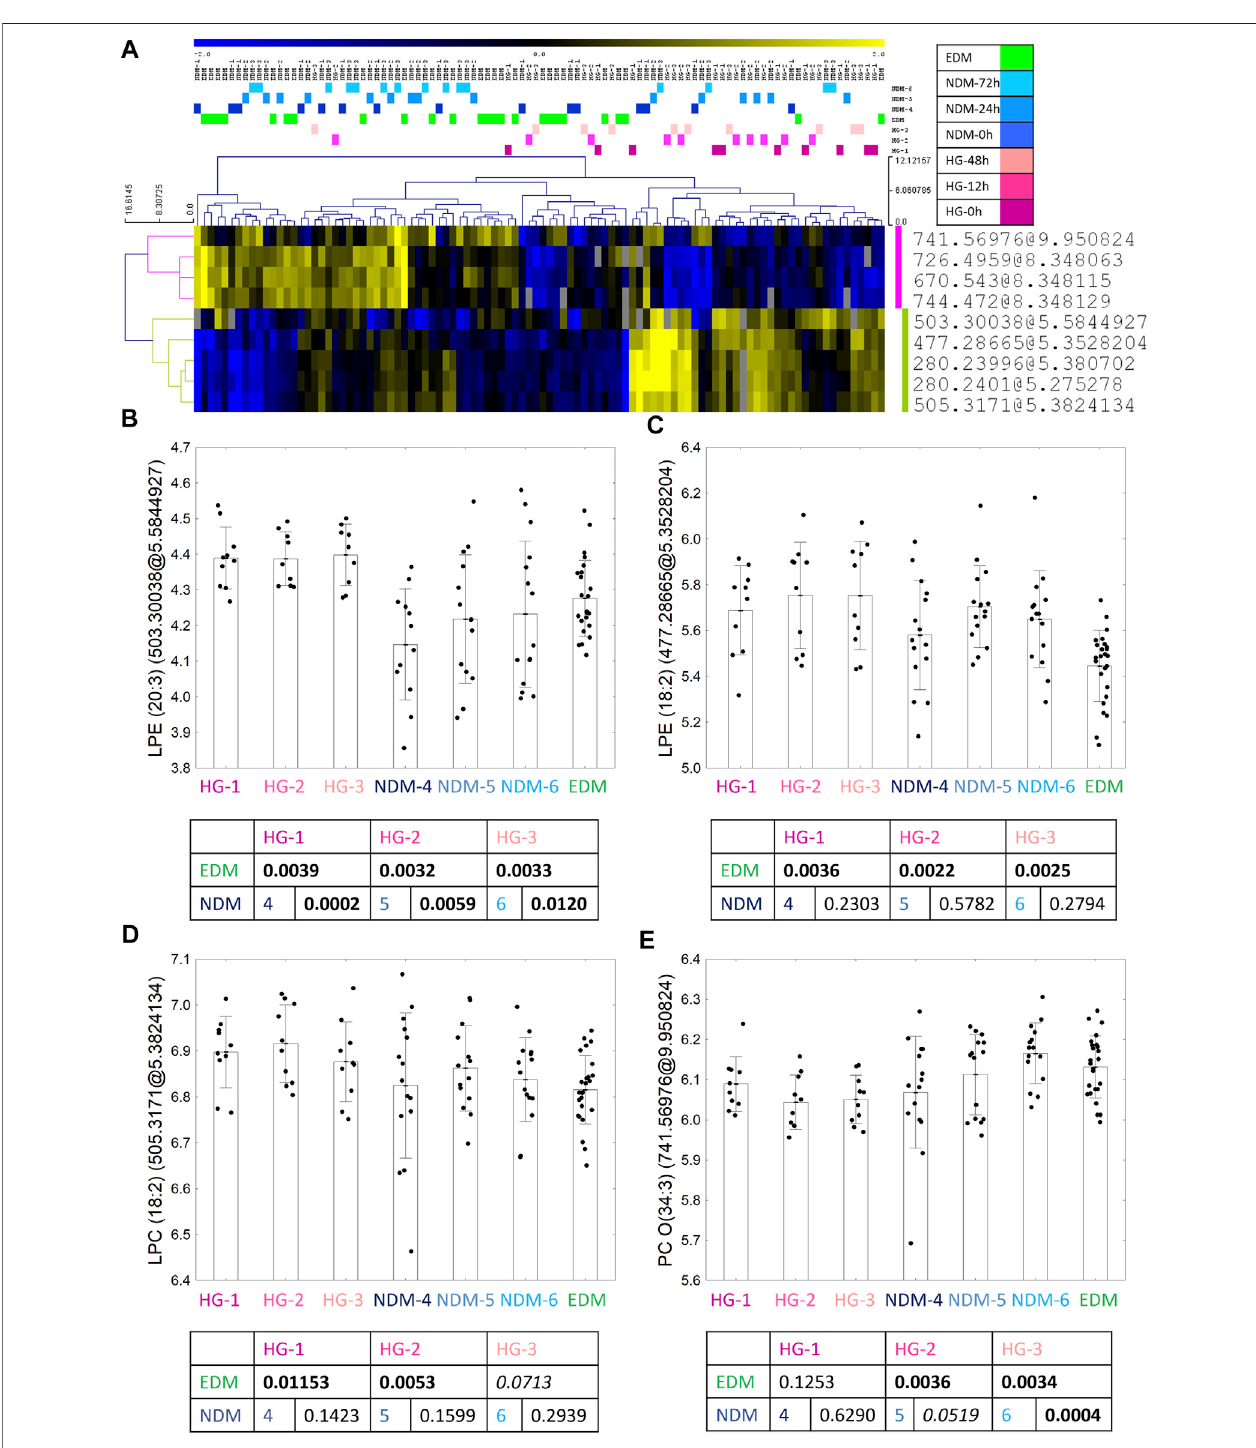
FIGURE3| Ninemetabolicfeaturesselected inthestatisticalanalysis asthe biomarkers ofHGoccurrence (A) .Between the grouppro fi le ofidenti fi ed metabolites: LPE (20:3) (B) , LPE (18:2) (C) , LPC (18:2) (D) and PC O(34:3) (E) . Uncorrected t -test p values are shown in the graphs.